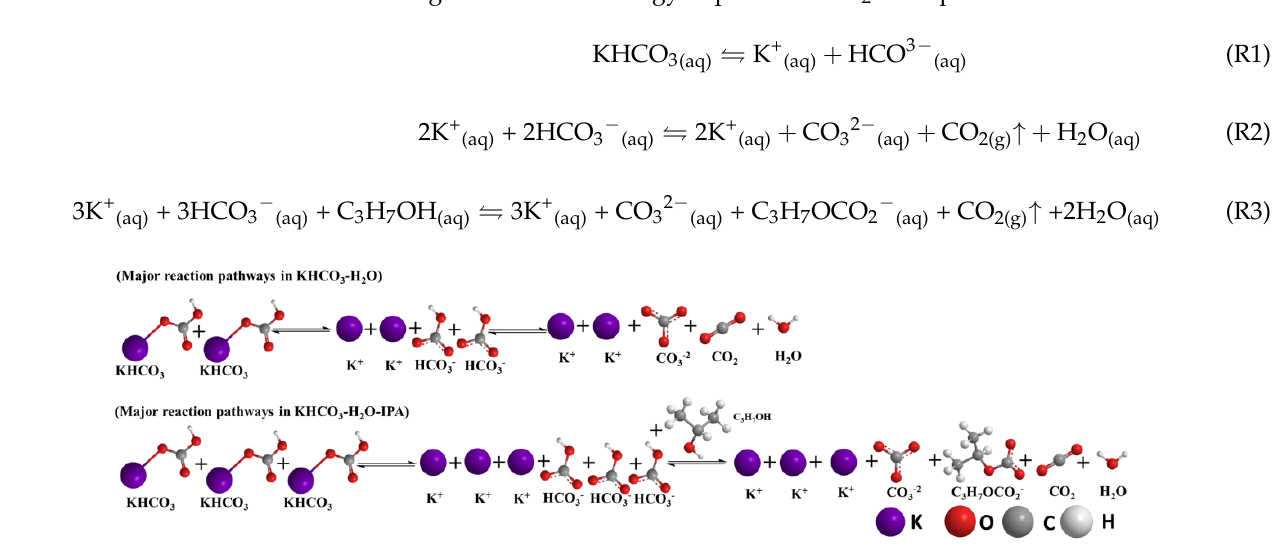
Figure 8. Major reaction pathways of CO 2 capture with KHCO 3 − H 2 O and KHCO 3 − H 2 O − IPA solutions.